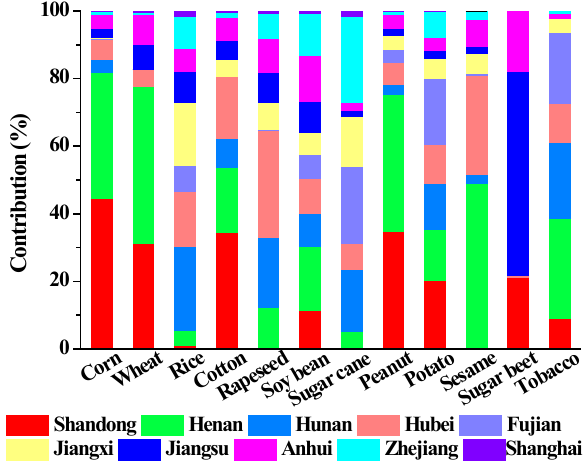
Figure 4. The averaged contributions of various crop straw burning to cropland PM 2 . 5 emission in different provinces.